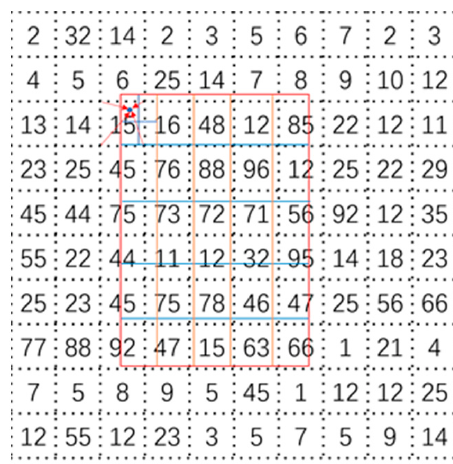
Figure 4. ROI Align structure.